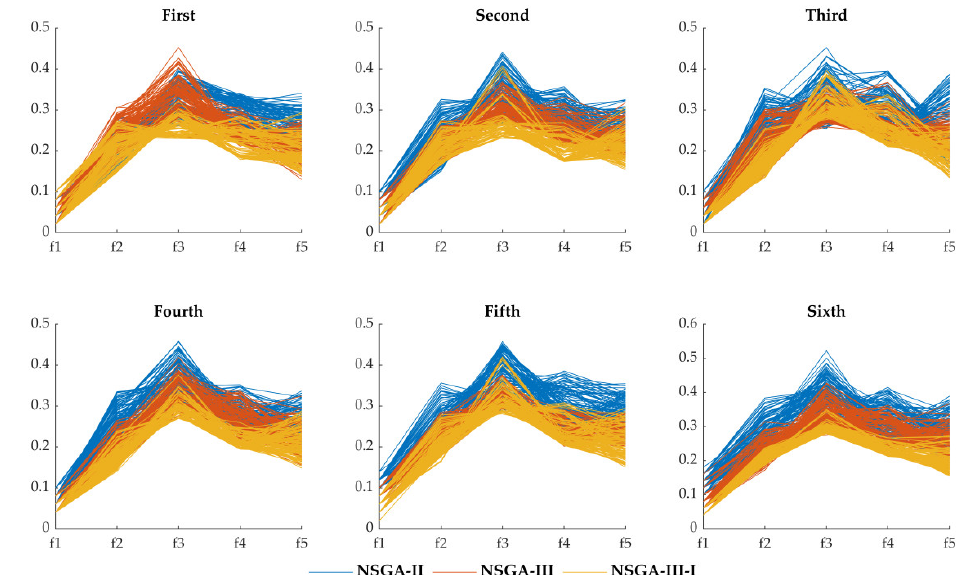
Figure 13. Parallel coordinate graph of the solution set of three types of algorithms in the first set of experiments.